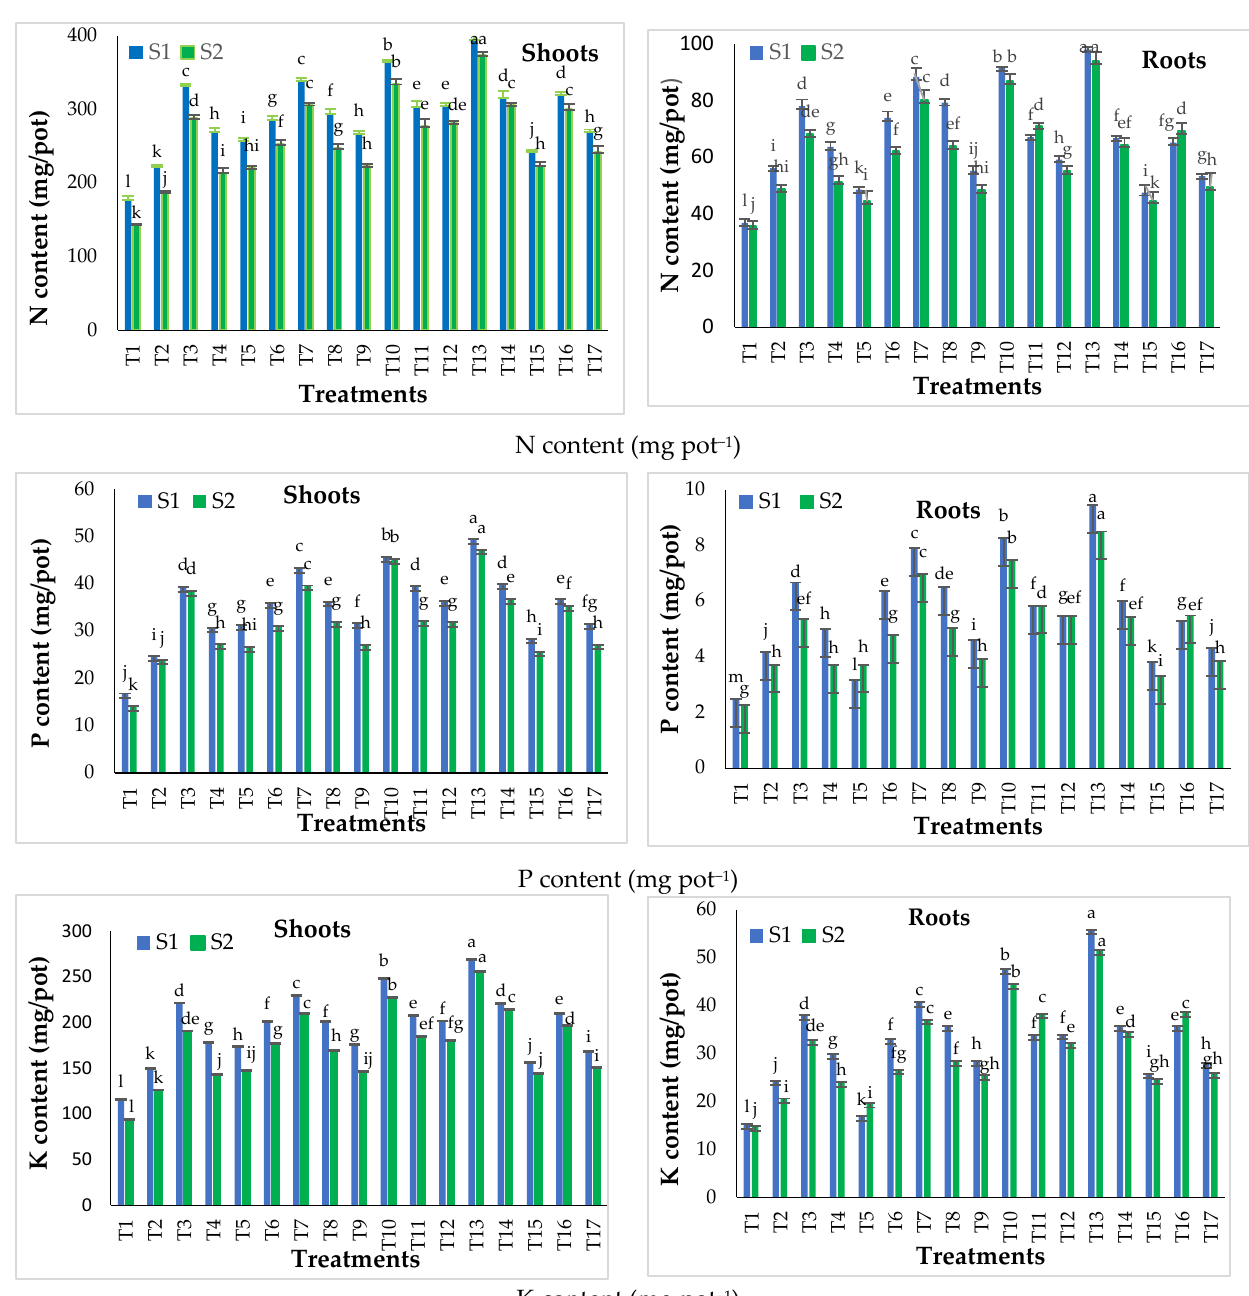
Figure 5. Effect of different phosphorus treatments on the nutrients content in shoot and root of snap bean plants at 45 days after sowing during the two seasons: S1 = season 2016–2017 and S2 = season 2017–2018. Data presented are means ± SD ( n = 3). Different letters mean values indicate significant differences at p ≤ 0.05, according to the least significance dif- ference.